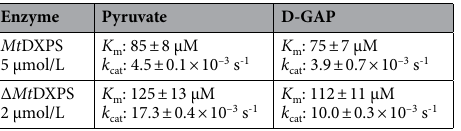
Table 1. Comparison of the enzyme kinetics from Mt DXPS and Δ Mt DXPS.